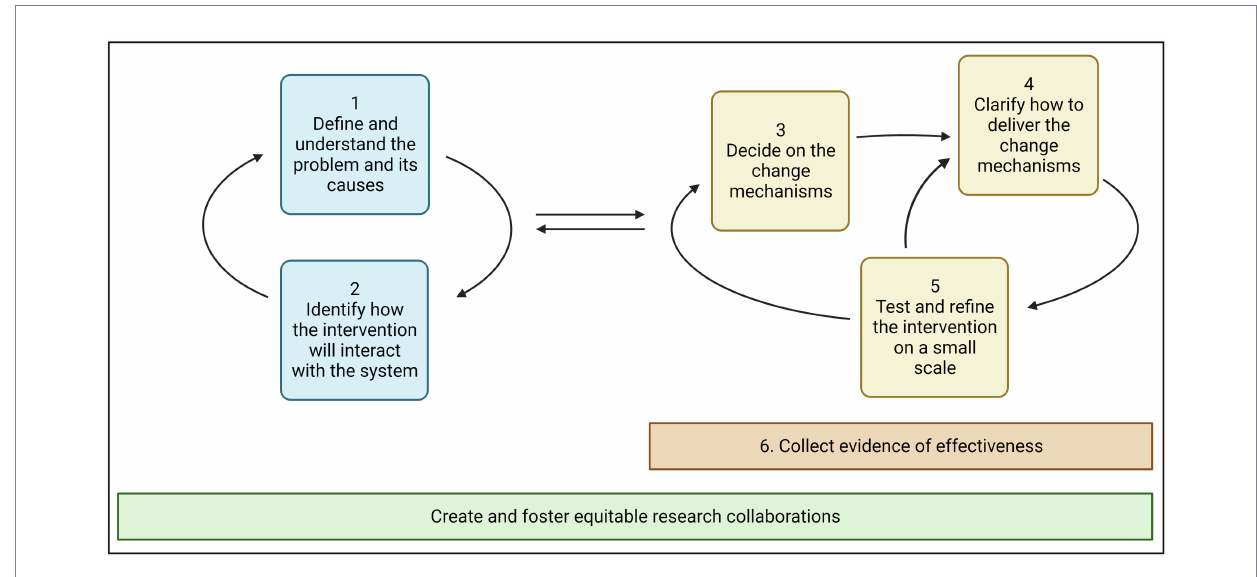
FIGURE 3 A dynamic and non-linear modification to the six essential steps for quality intervention development (6SQuiD)